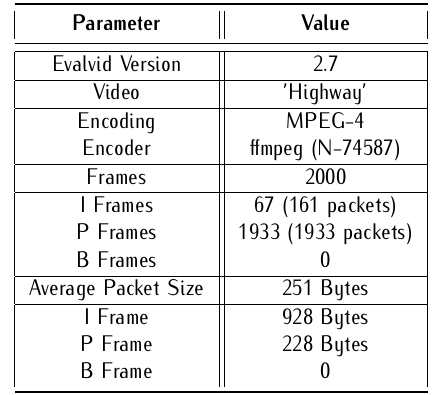
Table 2. EvalVid and Video Characteristics